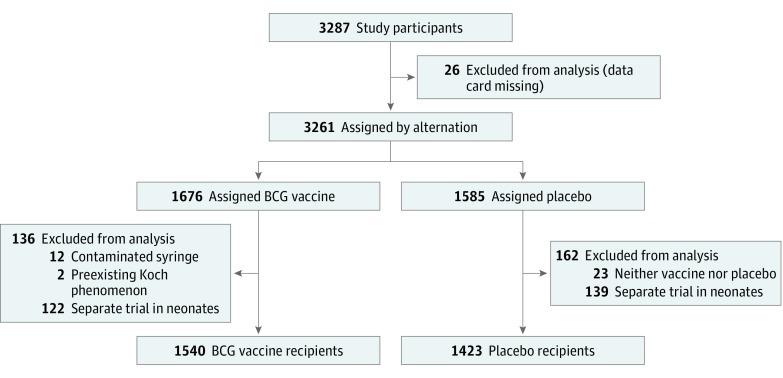
Study Flow Diagram